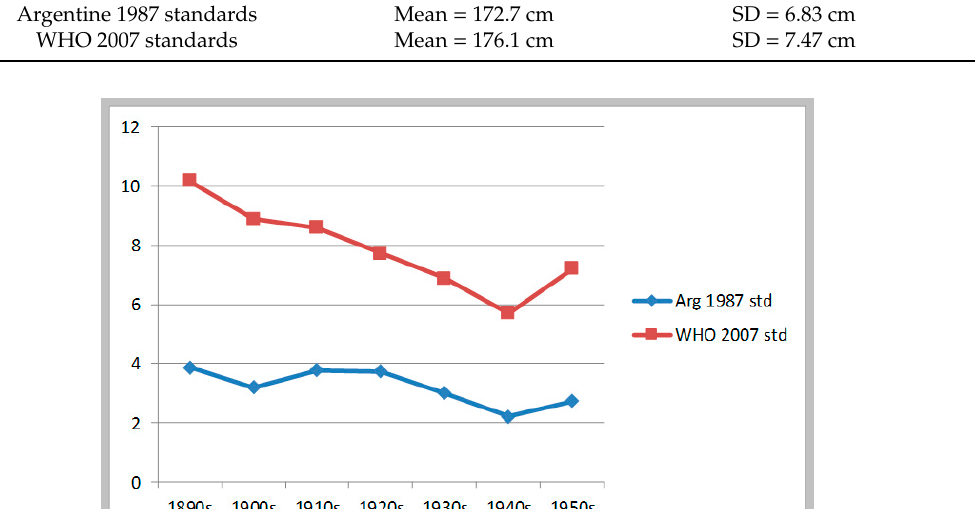
Figure 4. Evolution of moderate & severe stunting. Inmates of Buenos Aires Prisons, b.1885-1959.